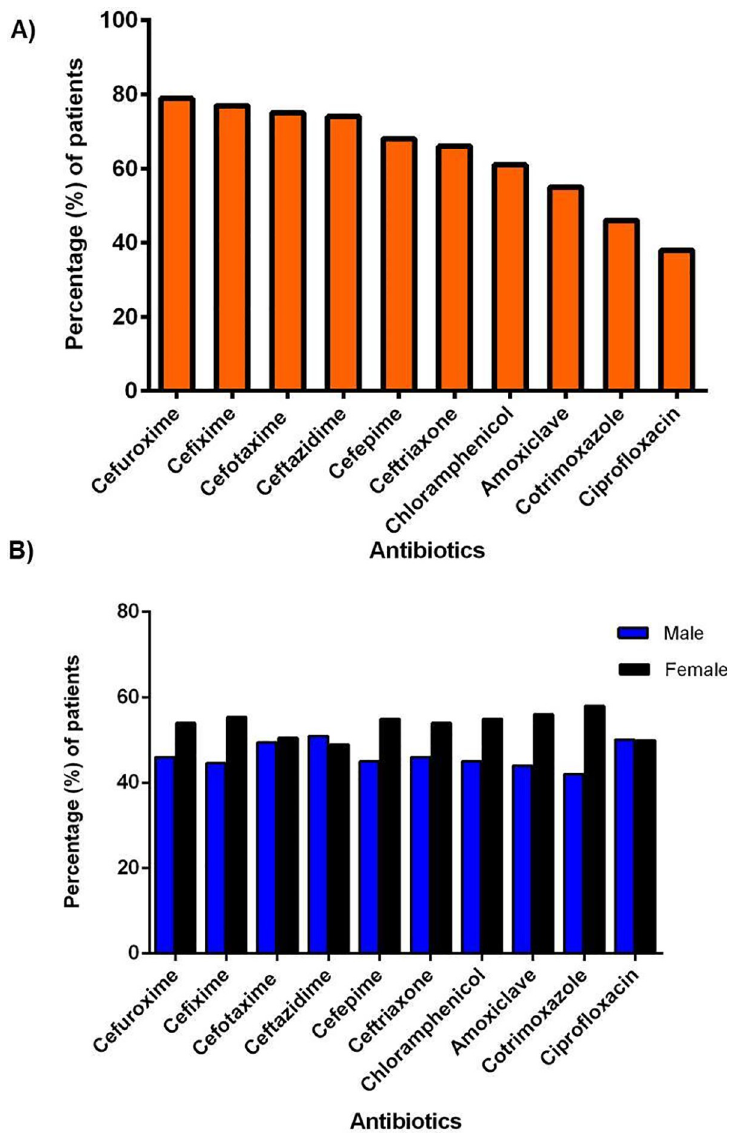
Fig 1. Patterns of antimicrobial resistance among Klebsiella pneumonia isolates collected from two hospitals. (A) Most resistant 10 antibiotics among study samples; (B) Gender wise frequency of antimicrobial resistance in KPN